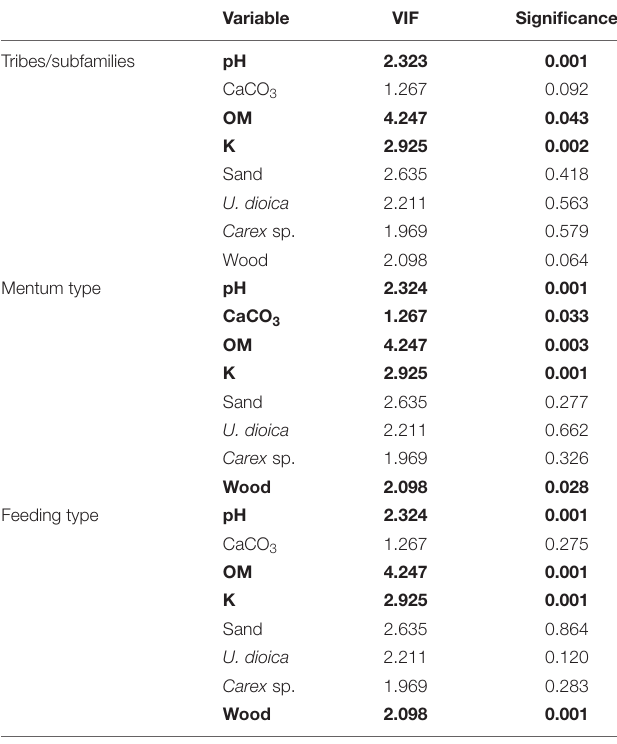
TABLE 2 | Variance influence factors (VIFs) and significance of eight environmental factors selected from correlation matrices. Variable